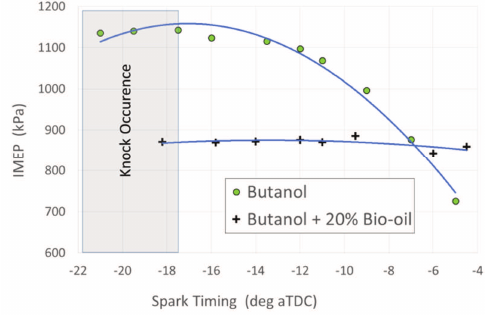
Fig. 4. Indicated mean effective pressure vs. spark